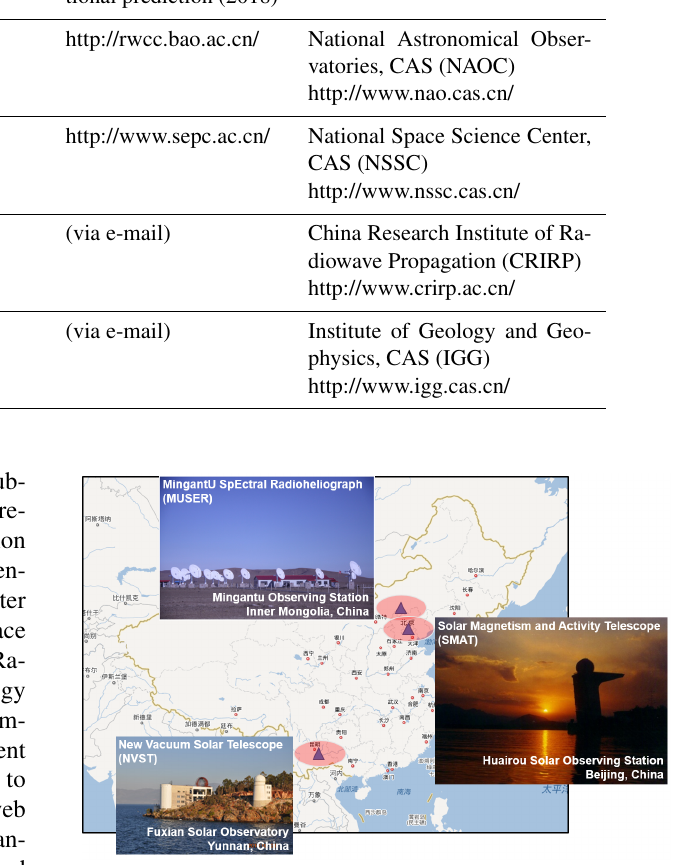
Figure 2. A map of the three solar observation instruments SMAT, NVST, and MUSER constructed in the new century.